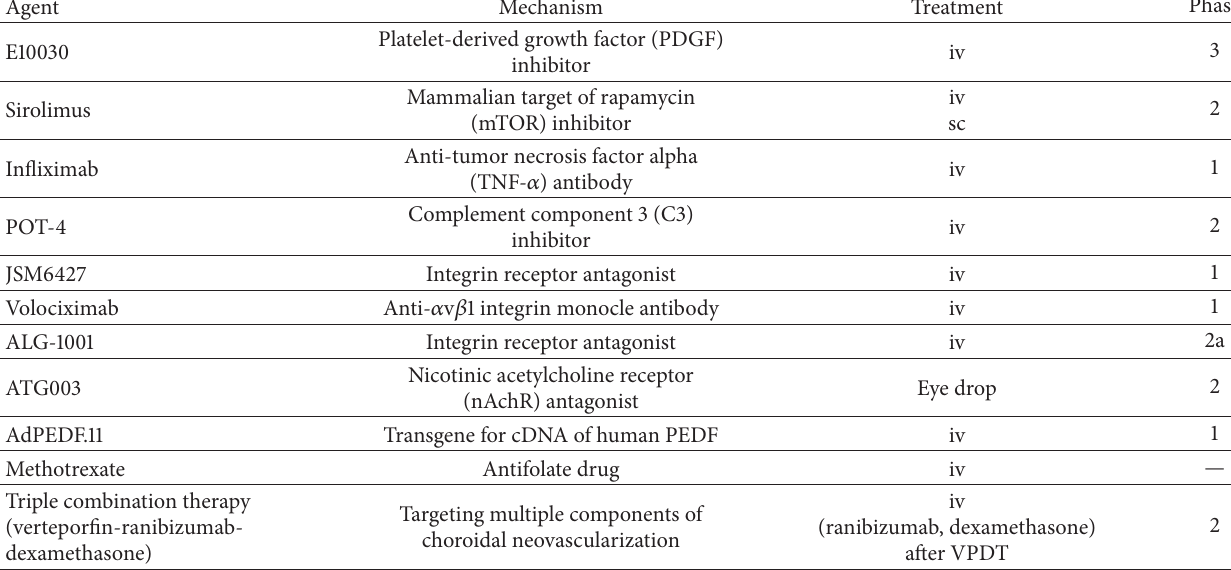
Table 1: Summary of neovascular AMD therapeutic agents, mechanisms, route, and phase of